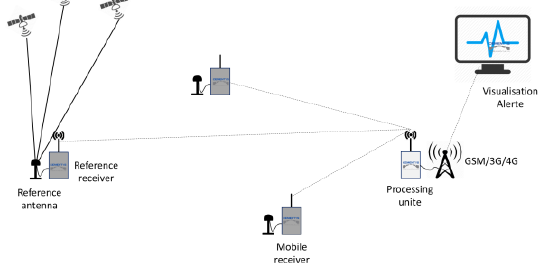
Figure 2. Low-cost monitoring system